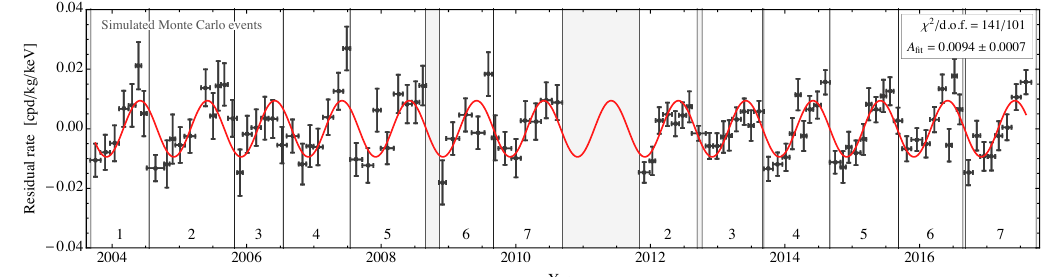
Figure 3 . Residuals obtained from the simulated data of (cid:12)gure 2 (black points) and computed within each data-taking cycle (vertical lines) following the DAMA procedure. The red curve shows the best (cid:12)t to the simulated residuals with a DM cosine signal with a period of one year and peaked on June, 2nd. The zero-signal hypothesis is excluded with a signi(cid:12)cance of 12 : 7 (cid:27) despite that no modulation was assumed in the simulated